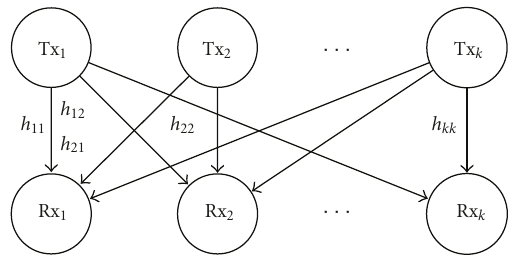
Figure 1: Assumed communication model: a K -user interference